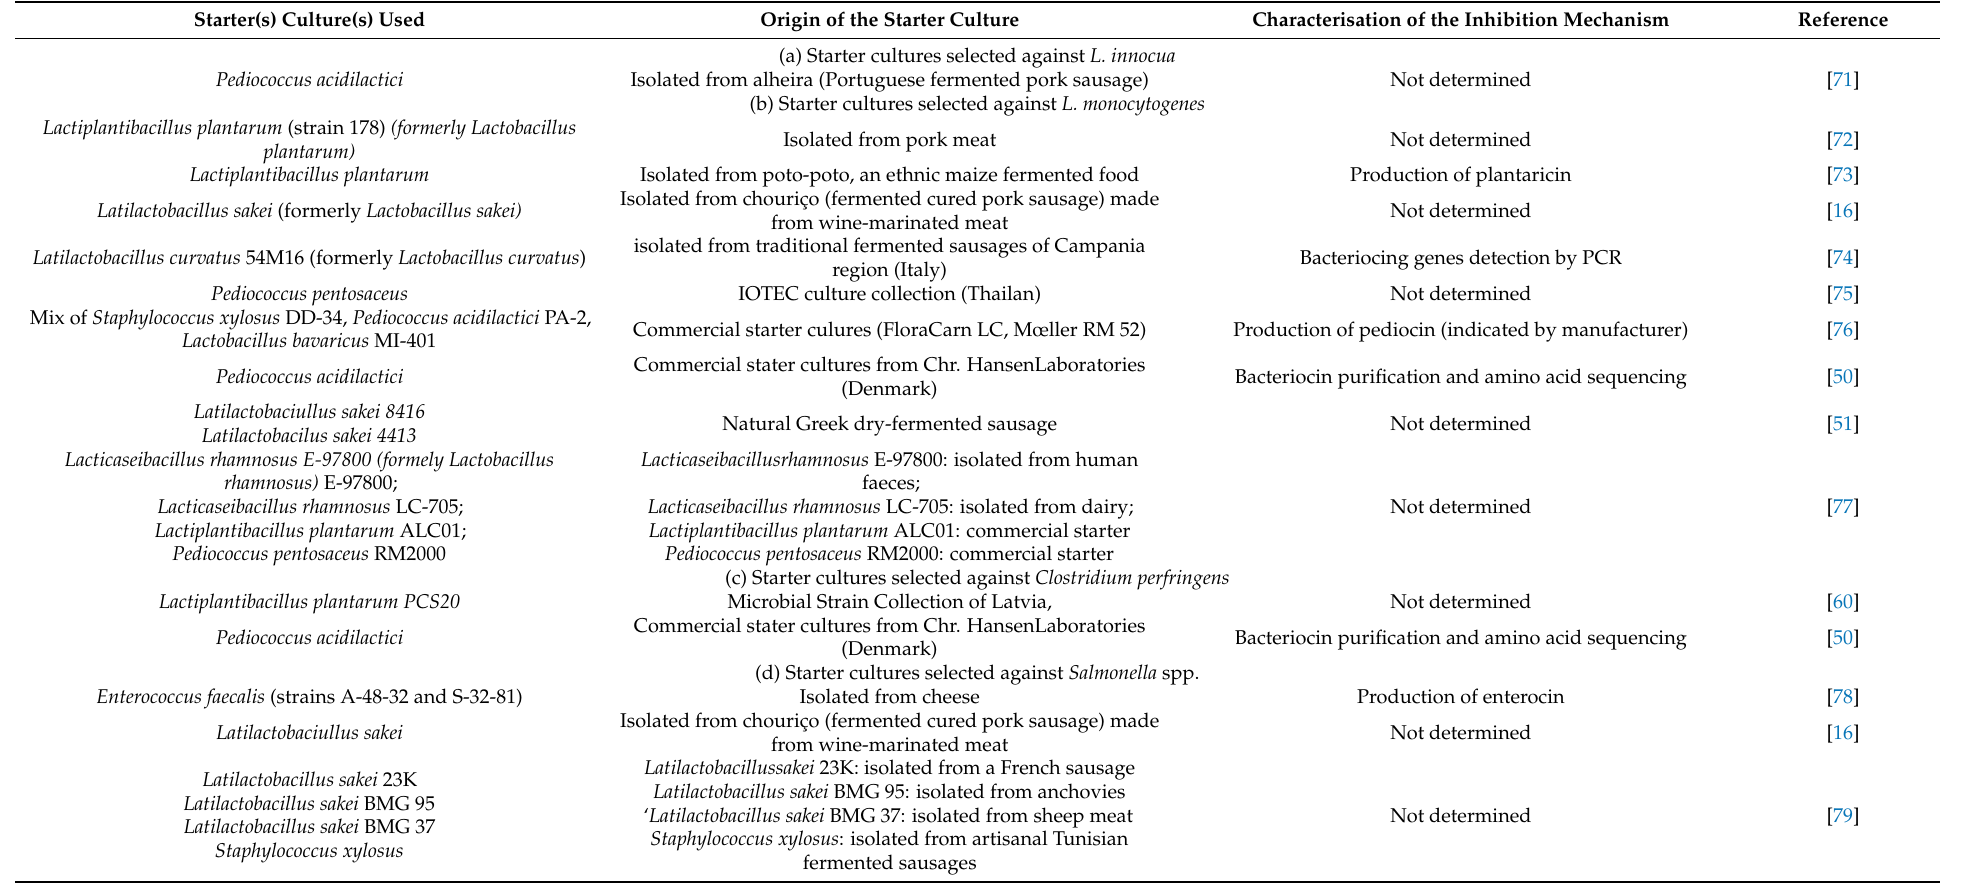
Table 1. Antimicrobial effect of selected starter cultures (added as ingredients during fermented meat manufacture) against main foodborne pathogens. Starter(s) Culture(s)